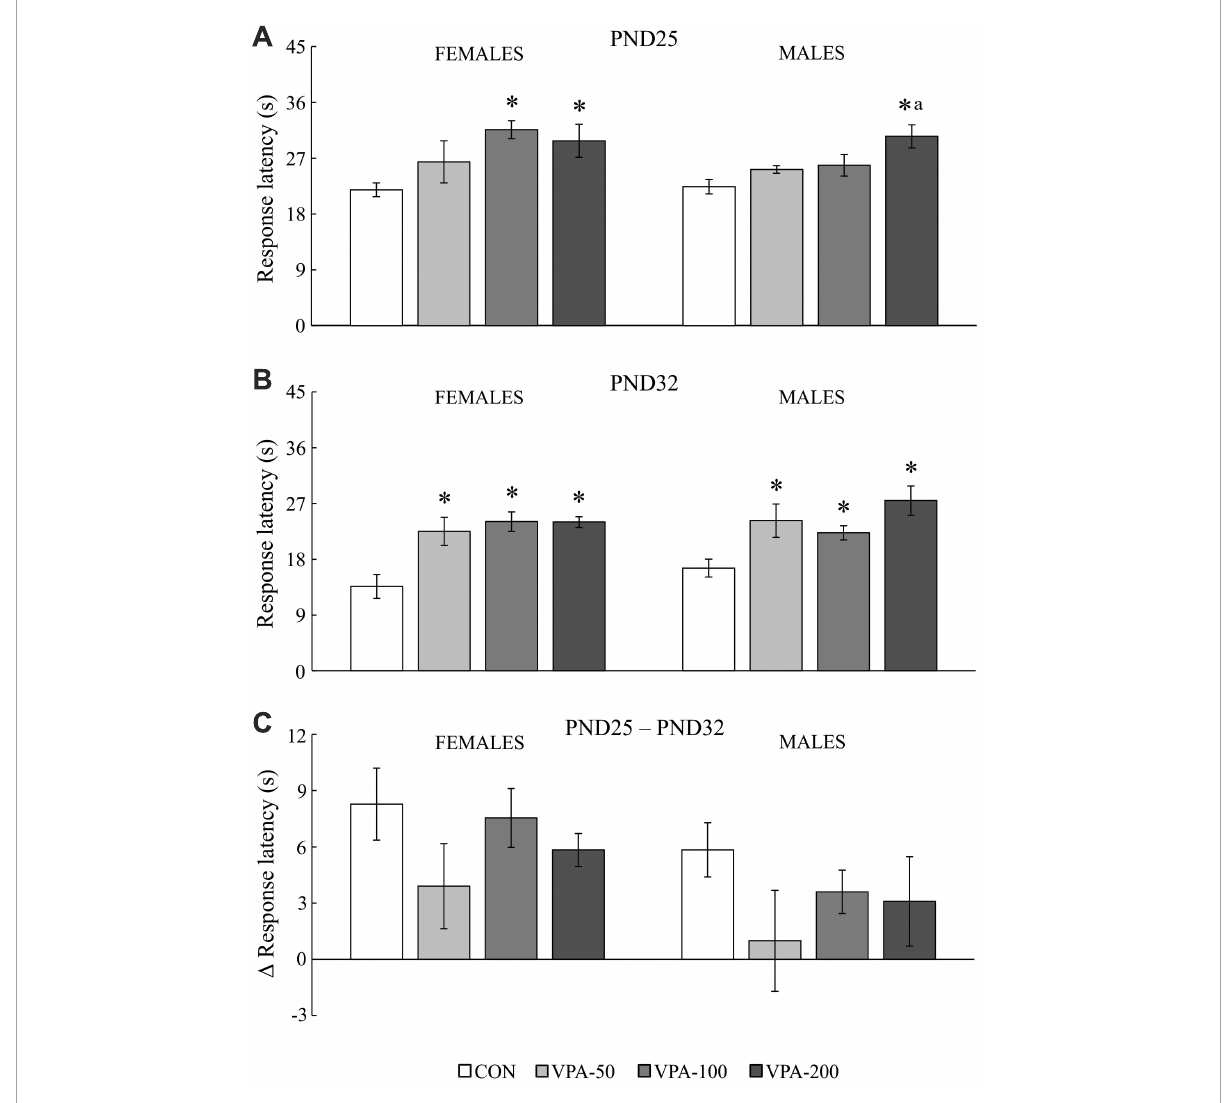
FIGURE3 The response latency to the thermal stimulus in adolescent female and male mice prenatally exposed to VPA at doses of 50 mg/kg (VPA-50), 100 mg/kg (VPA-100), and 200 mg/kg (VPA-200), which showed latencies less than 40 s in the hot plate test. The animals were tested on PND25 (A) and PND32 (B) ; based on the obtained parameters, the difference in response latency between two time points of interest was calculated (C) as the latency on PND25 (s) – latency on PND32 (s). Females and males in the VPA-400 group were not considered because a small number of them showed latencies less than 40 s. Each bar represents the mean ± SEM (CON group: n = 6 mice/sex; VPA groups: n = 5 mice/group/sex). * p < 0.05 compared to the control (CON) group treated with saline; a p < 0.05 compared to the VPA-50 group ( U